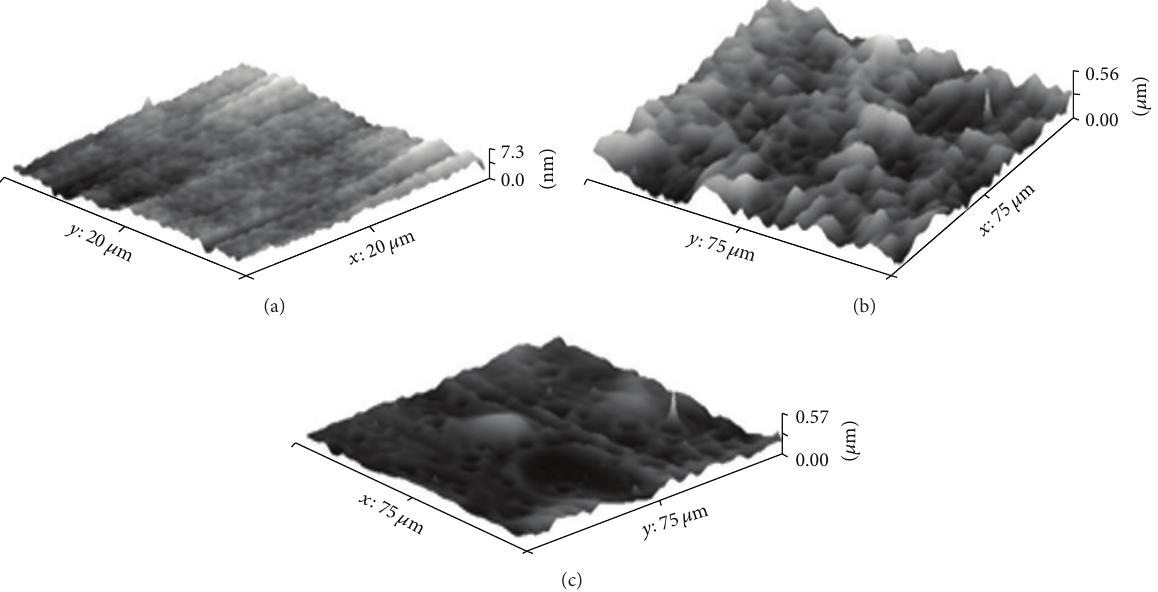
Figure 7: AFM-micrographs of (a) Si-wafer blank, (b) PAA coated Si-wafer, and (c) PAA/Ag after reduction spread on Si-wafer by means of